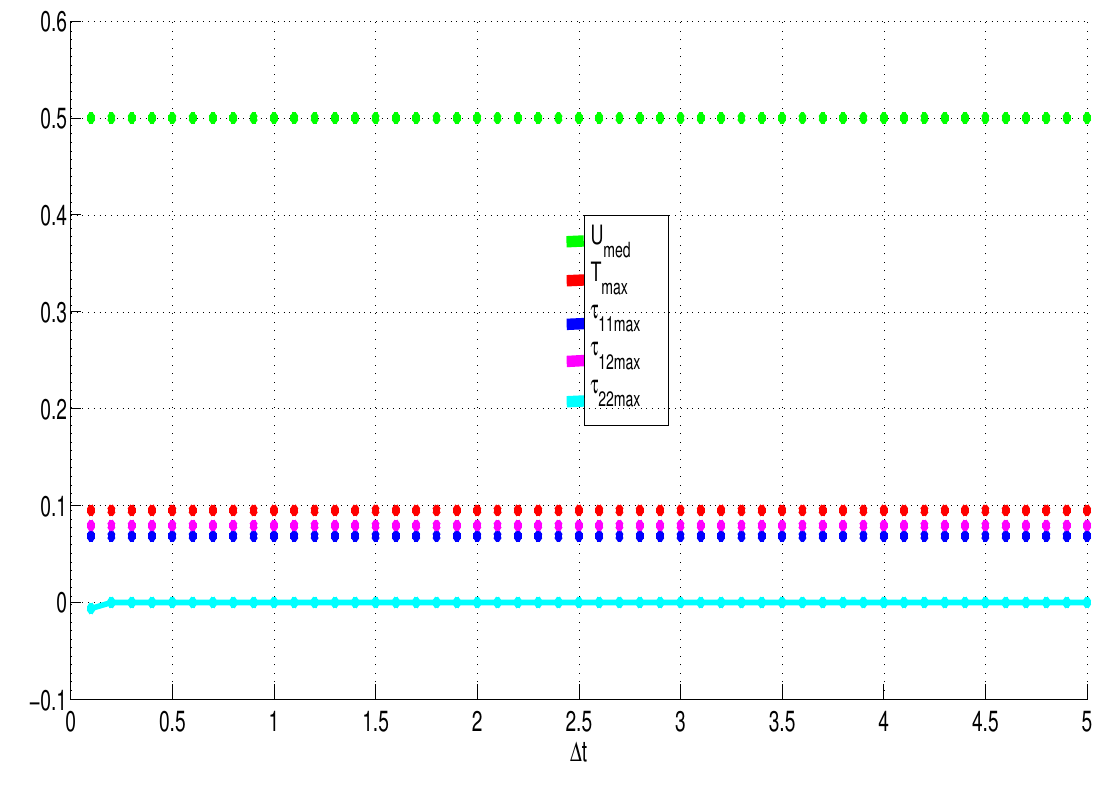
Figure 6. Dependence of solutions on time-step size.